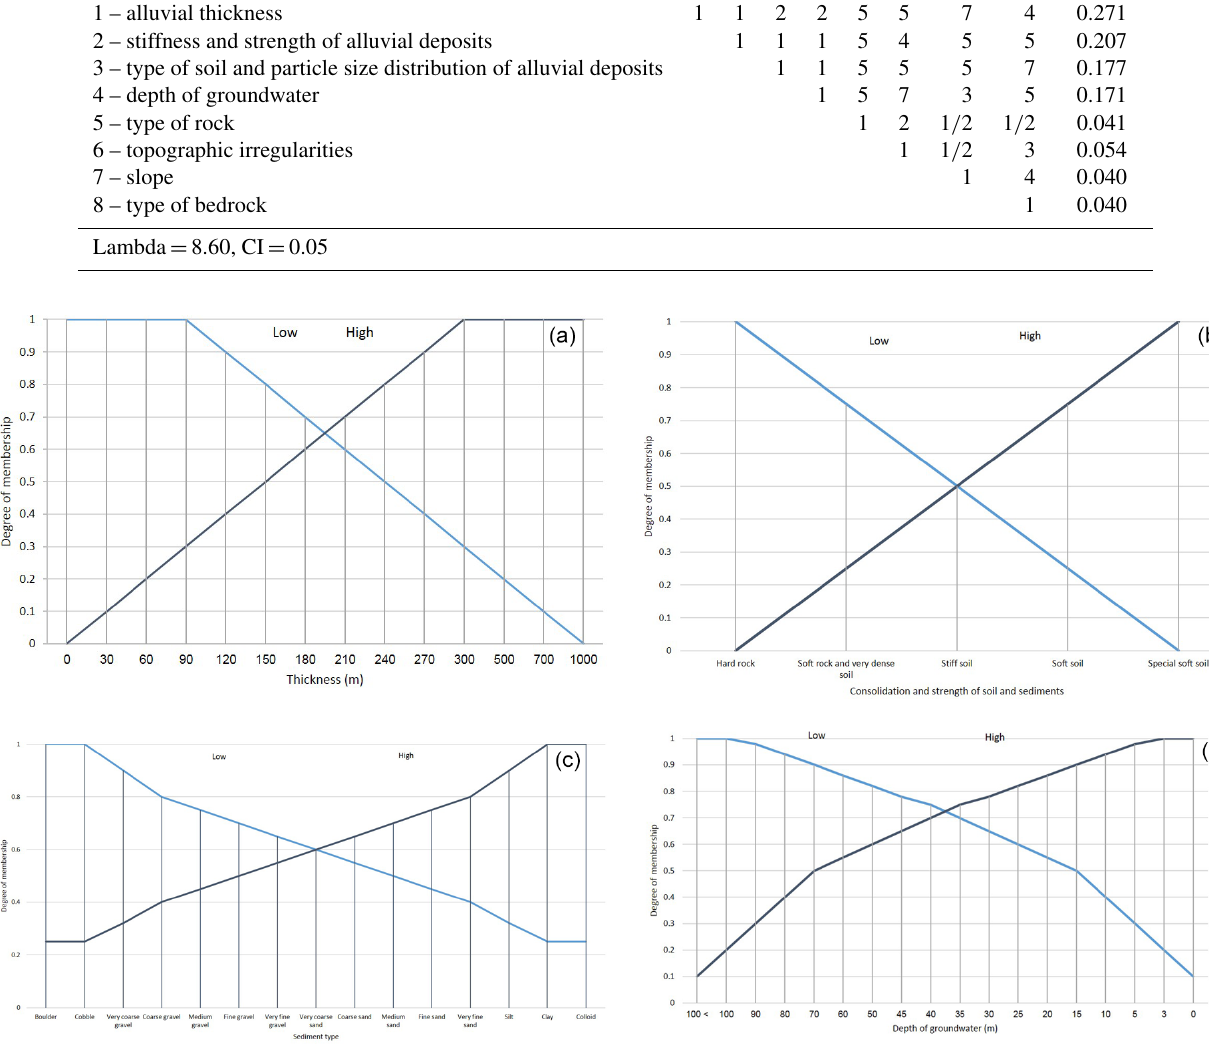
to water-saturated, cohesionless sediments and